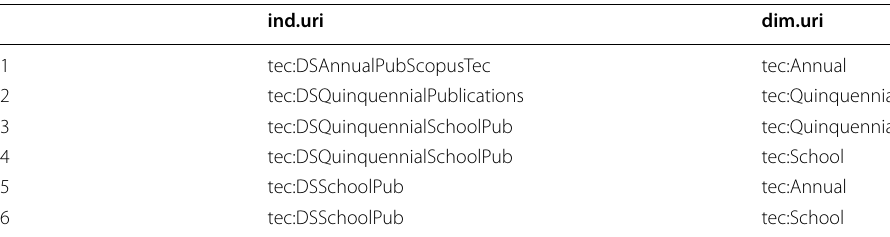
Table 4 Results for query: how is measured the number of